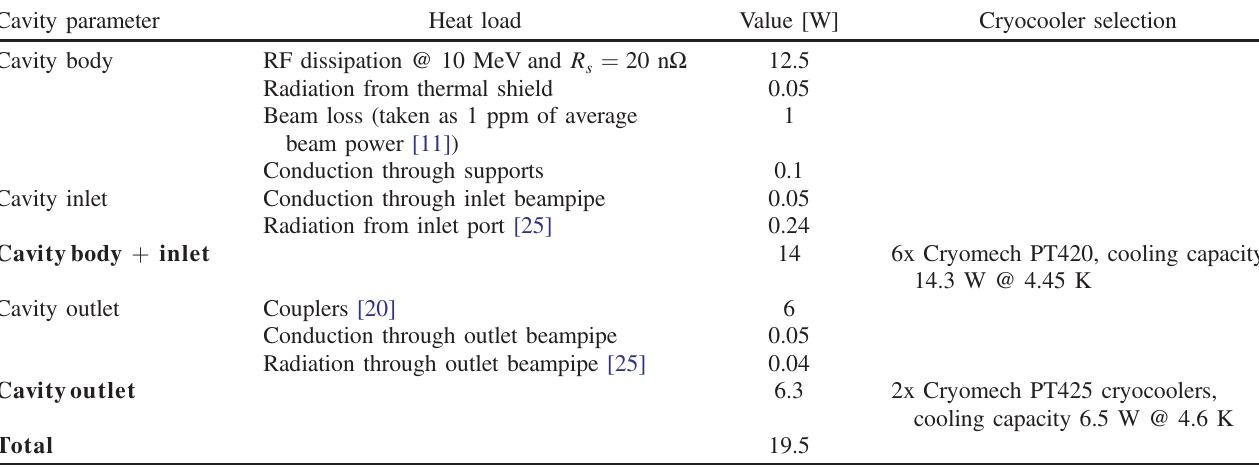
TABLE VII. Calculated heat load on the 5-cell SRF cavity.